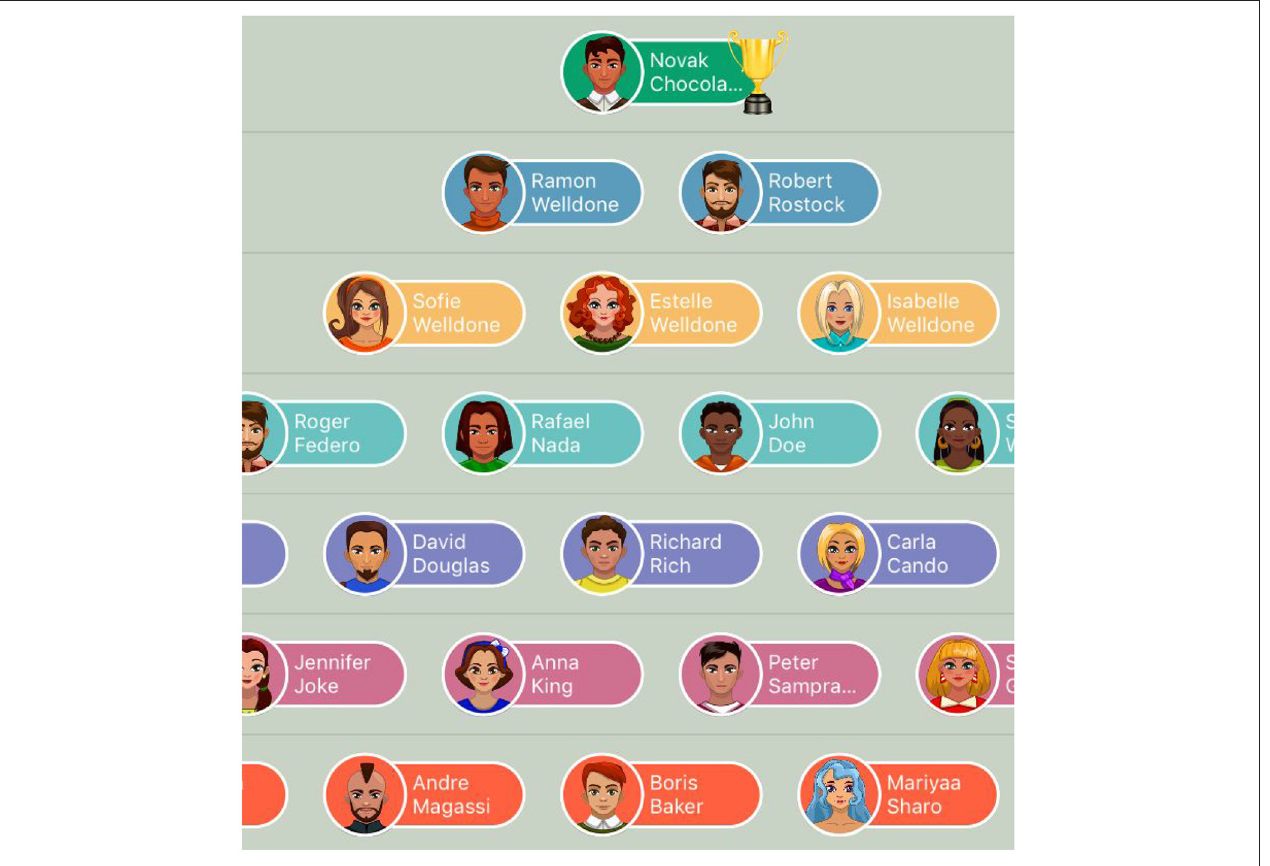
FIGURE 1 | Leaderboards can be used to present performance comparisons with other